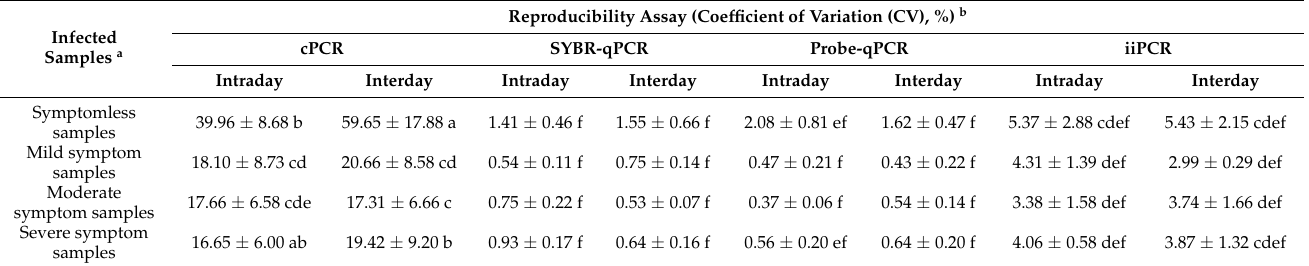
Table 2. Evaluation of reproducibility of the molecular detection assays using various Fusarium oxysporum -infected asymptomatic and symptomatic samples as testers.